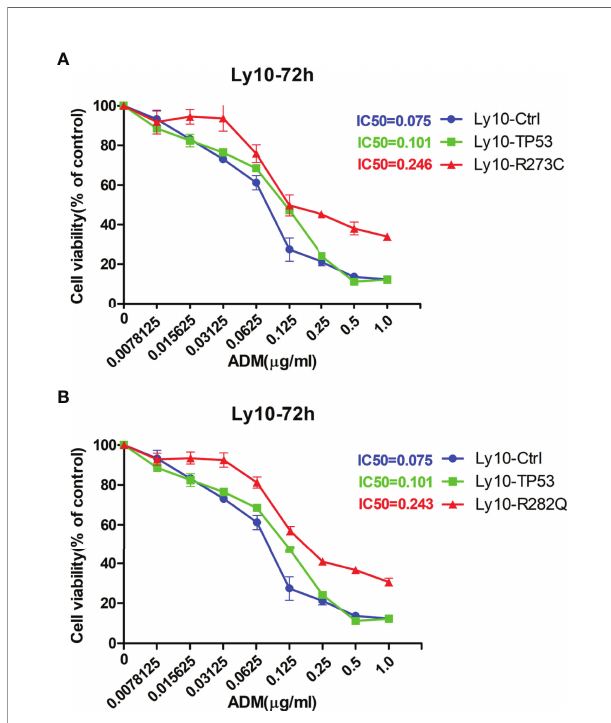
FIGURE 8 | p53 mutants (R273C and R282Q) induce doxorubicin resistance. (A, B) Effect of R273C (A) and R282Q (B) mutation on doxorubicin sensitivity in Ly10 cells. ADM, doxorubicin; Ly10-Ctrl, empty vector-transfected Ly10 cell; Ly10-R273C, p53 R273C mutant-transfected Ly10 cells; Ly10-R282Q, p53 R282Q mutant-transfected Ly10 cells; Ly10-TP53, wild-type p53-transfected Ly10